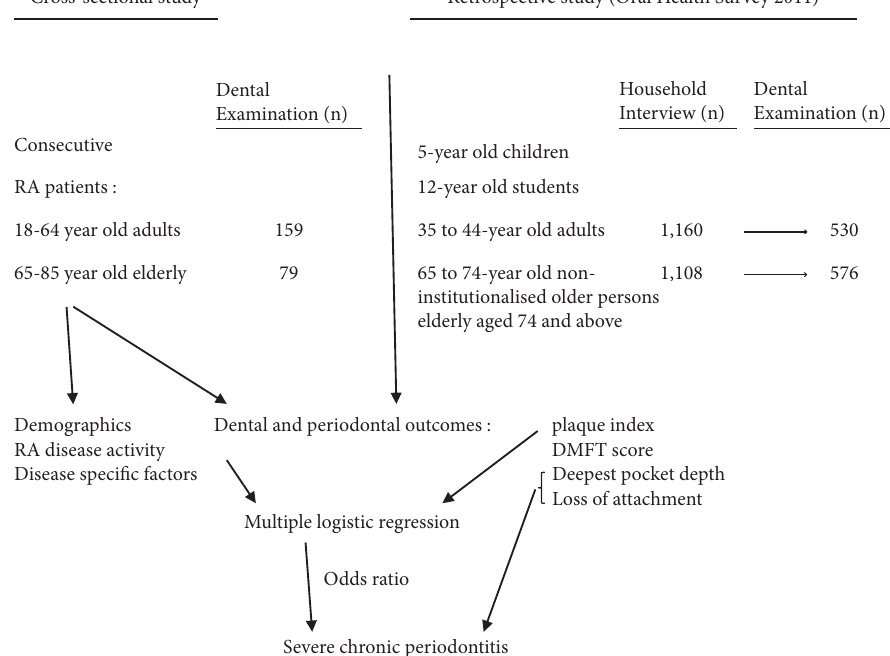
Figure 1: Diagram representation of the study design and